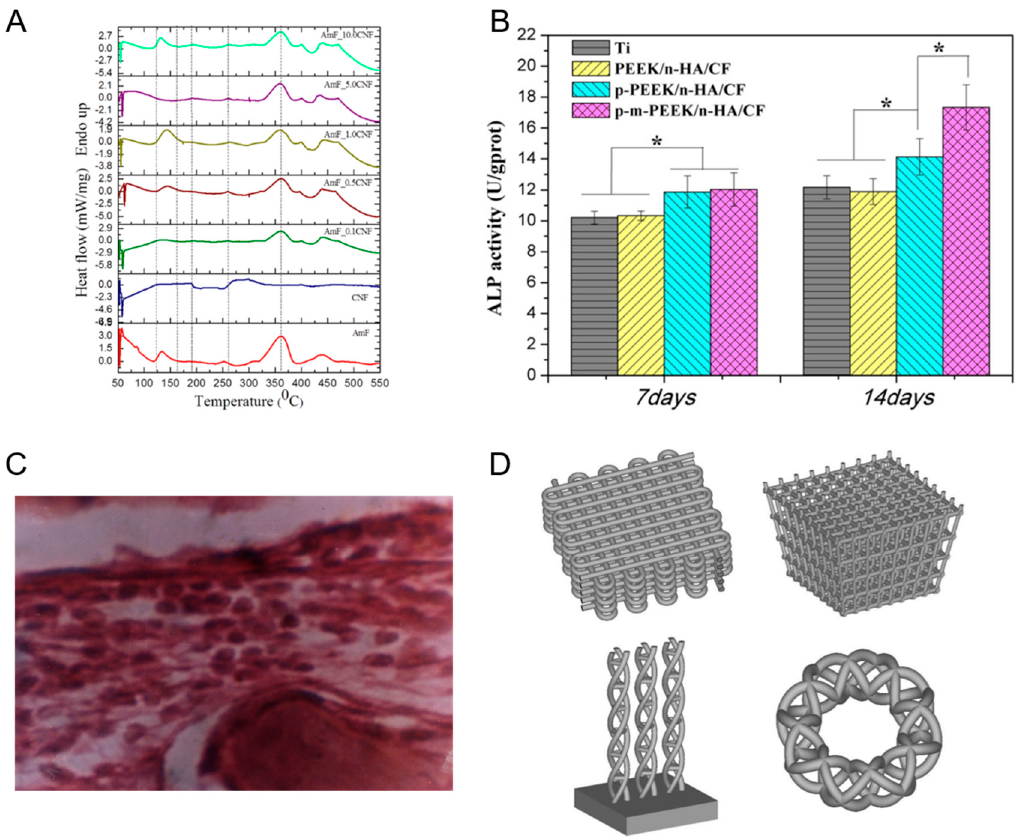
Figure 9. ( A ) Differential scanning calorimetry heat flow thermographs of the CF-based nanocomposite. Reproduced with permission from [74]. ( B ) Alkaline Phosphatase activities of MG-63 cells cultured on different implant materials. Reproduced with permission from [75]. ( C ) Histopathology of the newly formed bone in a rabbit. Reproduced with permission from [76]. ( D ) Computer aided designs of the 3D composite implant. Reproduced with permission from [78]. * Represents p <